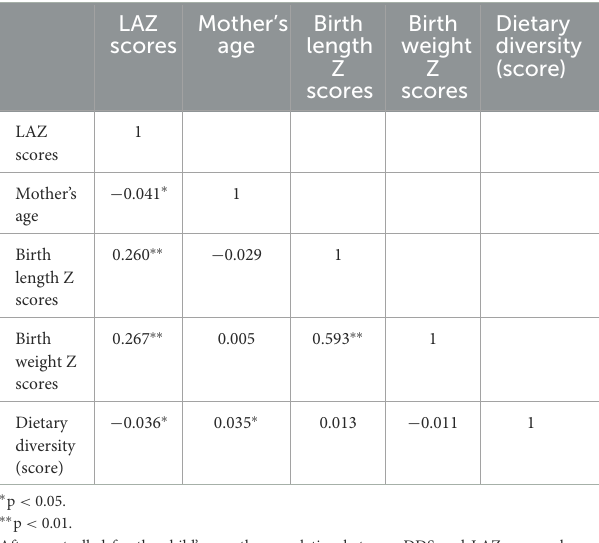
TABLE 2 Correlations between continuous variables ( n =